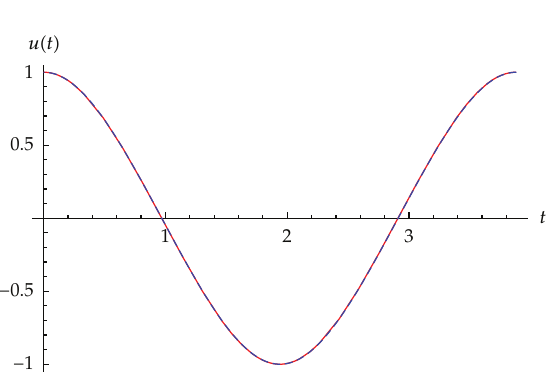
Figure 1: Comparison between the approximate solution (cid:2) 2.34 (cid:3) and numerical solution of (cid:2) 2.13 (cid:3) in Case a: a (cid:9) b (cid:9) A (cid:9) 1: dashed red line: numerical solution, dashed blue line approximate solution.